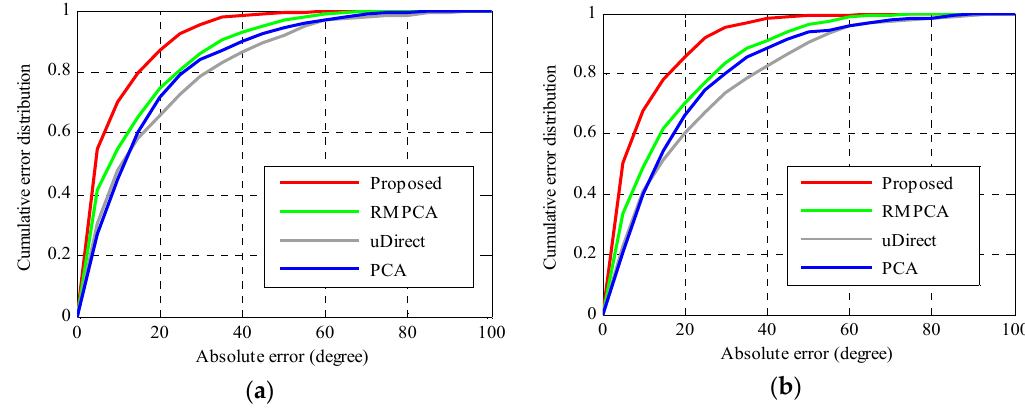
Figure 9. Absolute heading estimation error distributions with carrying position transitions in the second scenario: ( a ) Environment 1; ( b ) Environment 2.